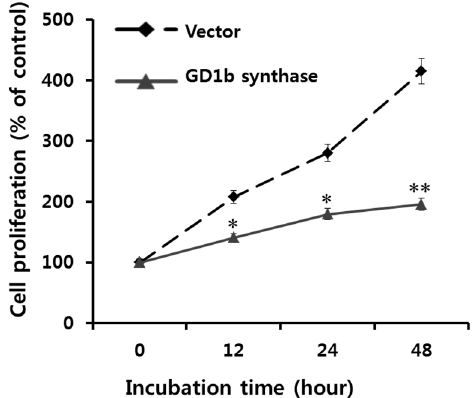
Figure 6. Effects of GD1b overexpression on the cell growth. The growth of vector- and GD1b-transfectant cells was evaluated using an XTT cell proliferation assay kit. Vector- and GD1b-transfectant cells were serum (+) incubated for 0, 12, 24 and 48 h. All data are reported as the percentage change in comparison with the control group, which were arbitrarily assigned 100% viability. Data represent five experiments (means ± sd). * p < 0.01 and ** p < 0.001 vs. vector (mock) transfectants, at each incubation time.